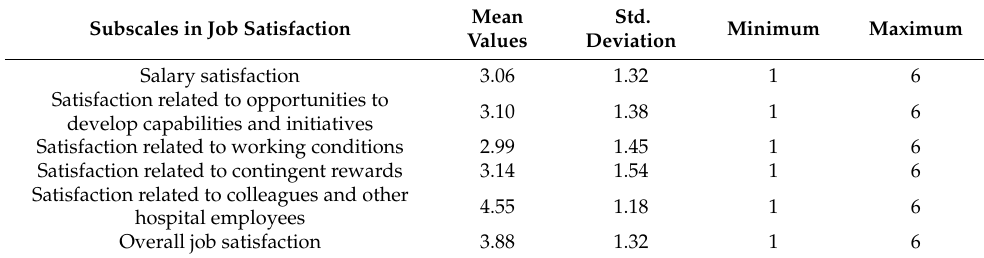
Table 6. An overview of selected job satisfaction subscales.